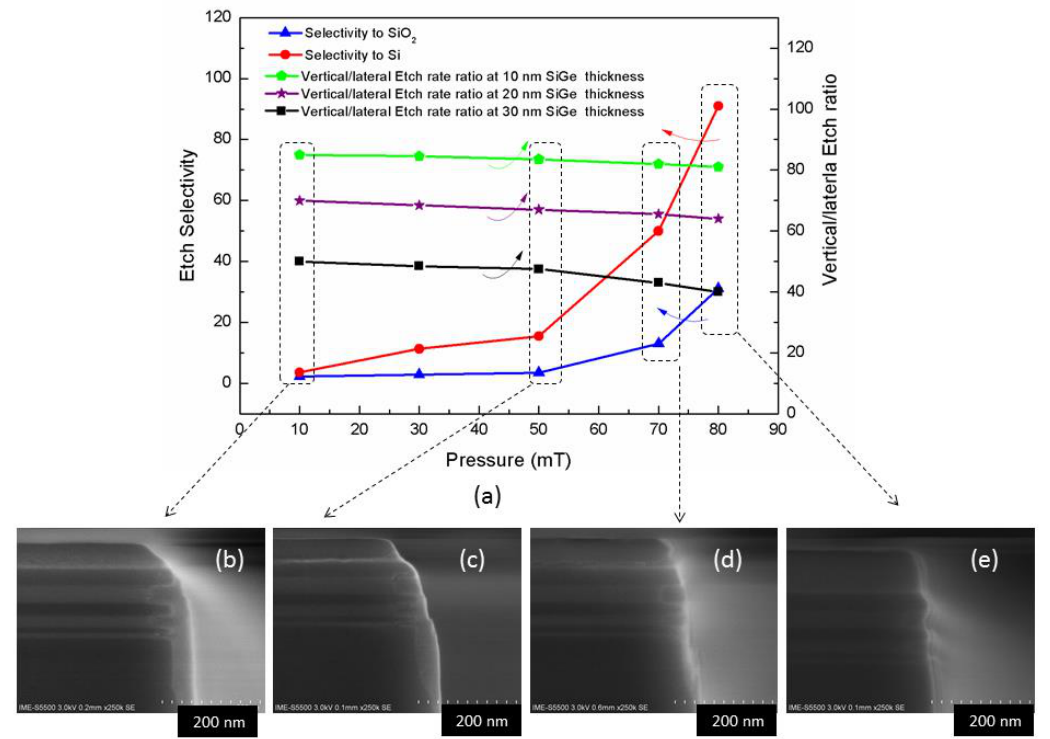
Figure 7. Effect of pressure on etching: ( a ) the dependence of etch selectivity and vertical/lateral etch ratio on pressure; ( b ) etching profile of 10mT; ( c ) etching profile of 50 mT; ( d ) etching profile of 70 mT; ( e ) etching profile of 80 mT.